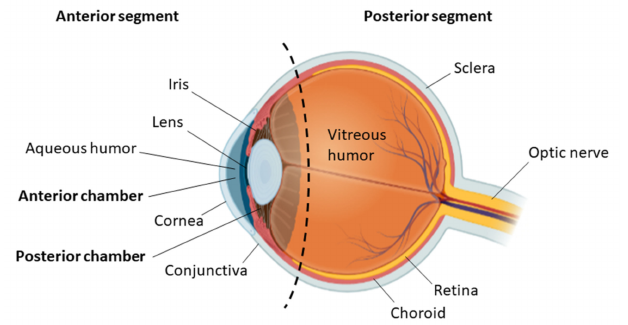
Figure 1. Anatomy of the vertebrate eye. This organ is divided into the anterior and posterior segments. The anterior segment comprises the anterior chamber, which is located between the cornea and the iris, and the posterior chamber, which extends from the iris to the lens. Adapted from Lin et al. (2019)